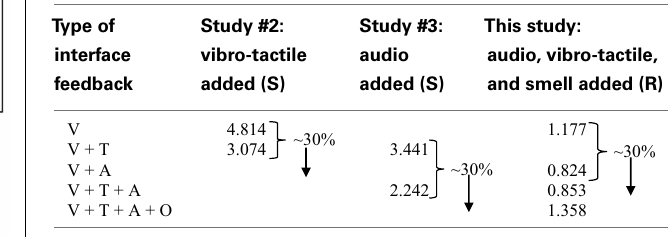
terms of the audio-enhanced Interface 2, although no SSD was found [ F (3, 44) = 1.048, p = 0.381, η 2 = 0.061].